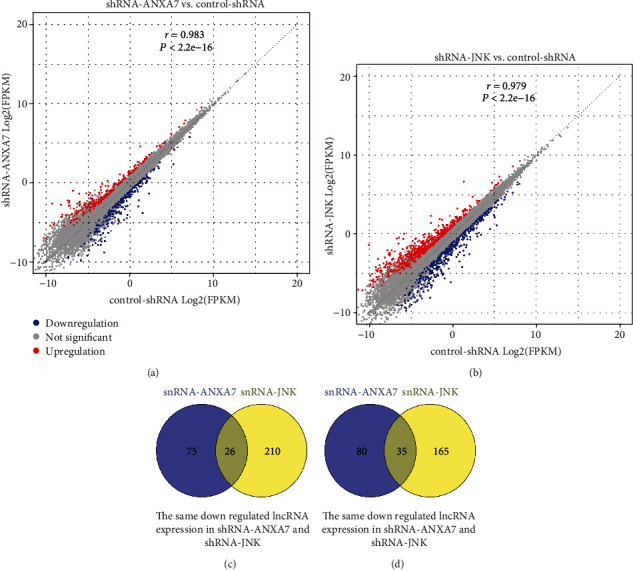
Long noncoding RNAs (lncRNAs) differentially expressed under ANXA7 or JNK knockdown in Hca-P hepatocellular carcinoma cells. (a). Express correlation scatter plot for the shRNA-ANXA7 group vs. control-shRNA group. Red represents upregulated, and blue represents downregulated lncRNAs. (b). Express correlation scatter plot for the shRNA-JNK group vs. control-shRNA group. Red represents upregulated, and blue represents downregulated lncRNAs. (c). Common lncRNAs downregulated by both ANXA7 and JNK knockdown. (d). Common lncRNAs upregulated by both ANXA7 and JNK knockdown.